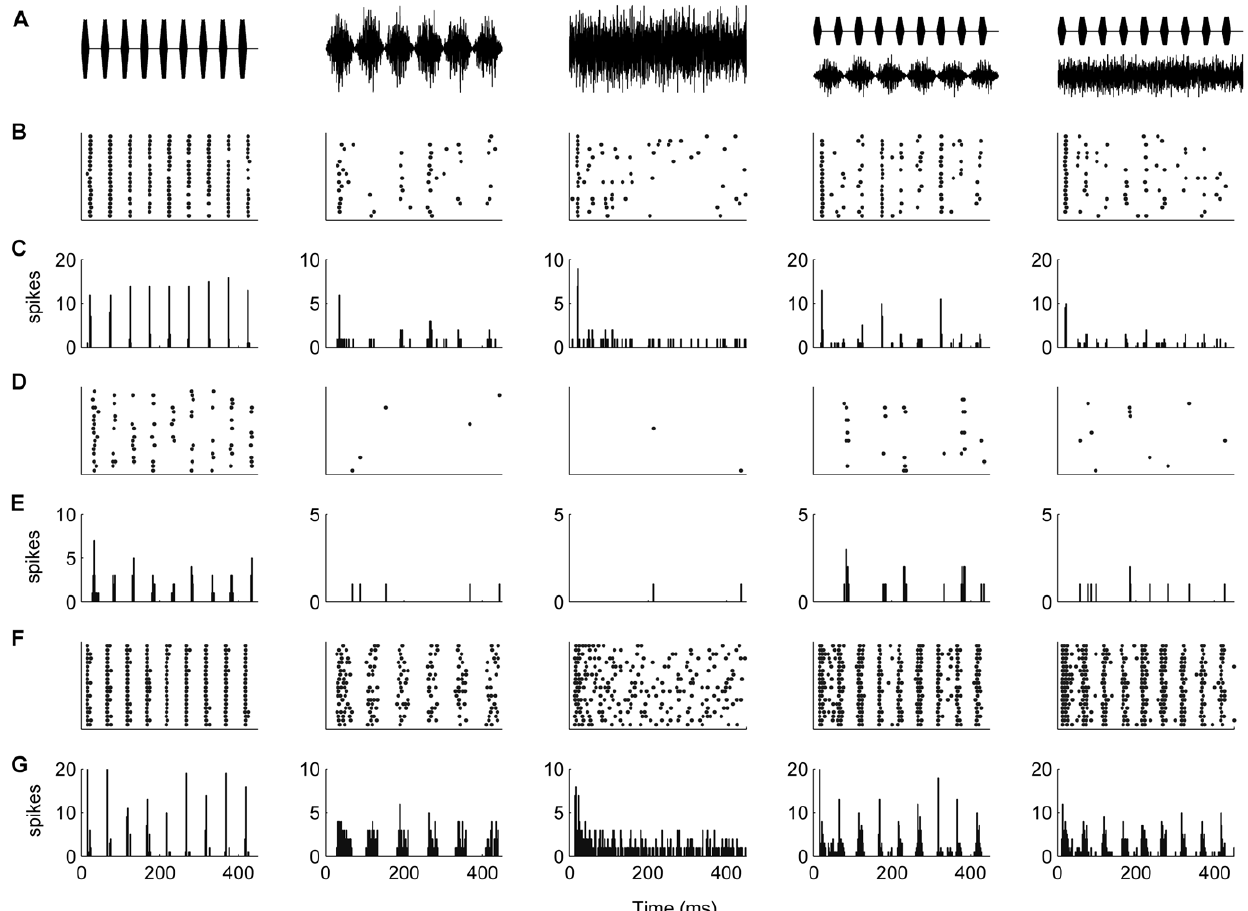
Figure 3. Firing patterns of different neurons. Rasterplots and peristimulus time histograms (PSTHs) showing the temporal firing patterns to P- alone (1 st column), wideband M m (2 nd column), wideband M u (3 nd column), P + M m (4 th column) and P + M u (5 th column) for three representative neurons ( B–G ). The stimuli are shown in ( A ). The binsize for the PSTHs was 2 ms. For the neuron in ( B , C ) and ( D, E ) addition of the masker degrades the temporal pattern of the response to the probe. In panels B and C , the probe responses occurring during the dips of the M m are unaffected (1 st , 4 th and 7 th pulse in the 4 th column), whereas the unit’s firing rate and time-locking to the probe are decreased when the probe coincides with the masker. For the neuron in ( D, E ) the presence of the masker severely disrupted the response to the probe. In the presence of modulated noise,